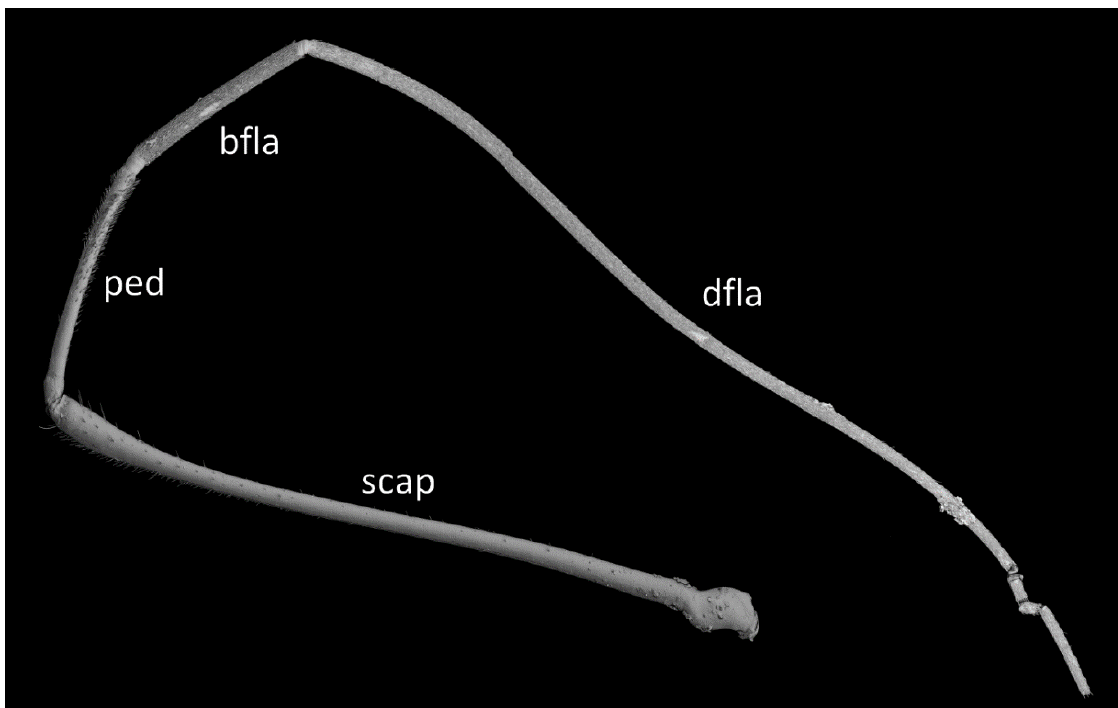
Figure 9. Antennae of Phonoctonus fasciatus (Beauvois, 1805). bfla — basiflagellomere; dfla — distiflagellomere; ped — pedicellus of antenna; scap — scapus of antenna.